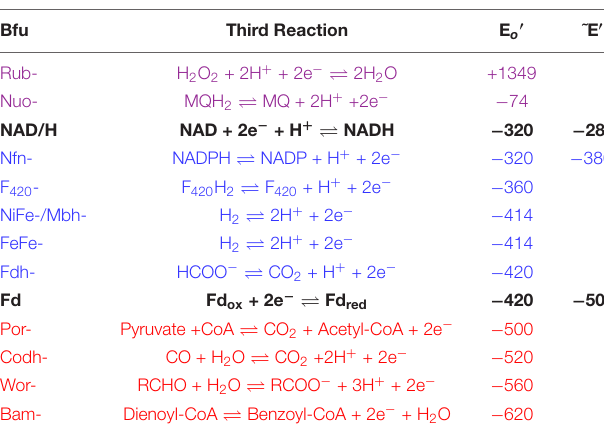
TABLE 1 | Third reactions of Bfu